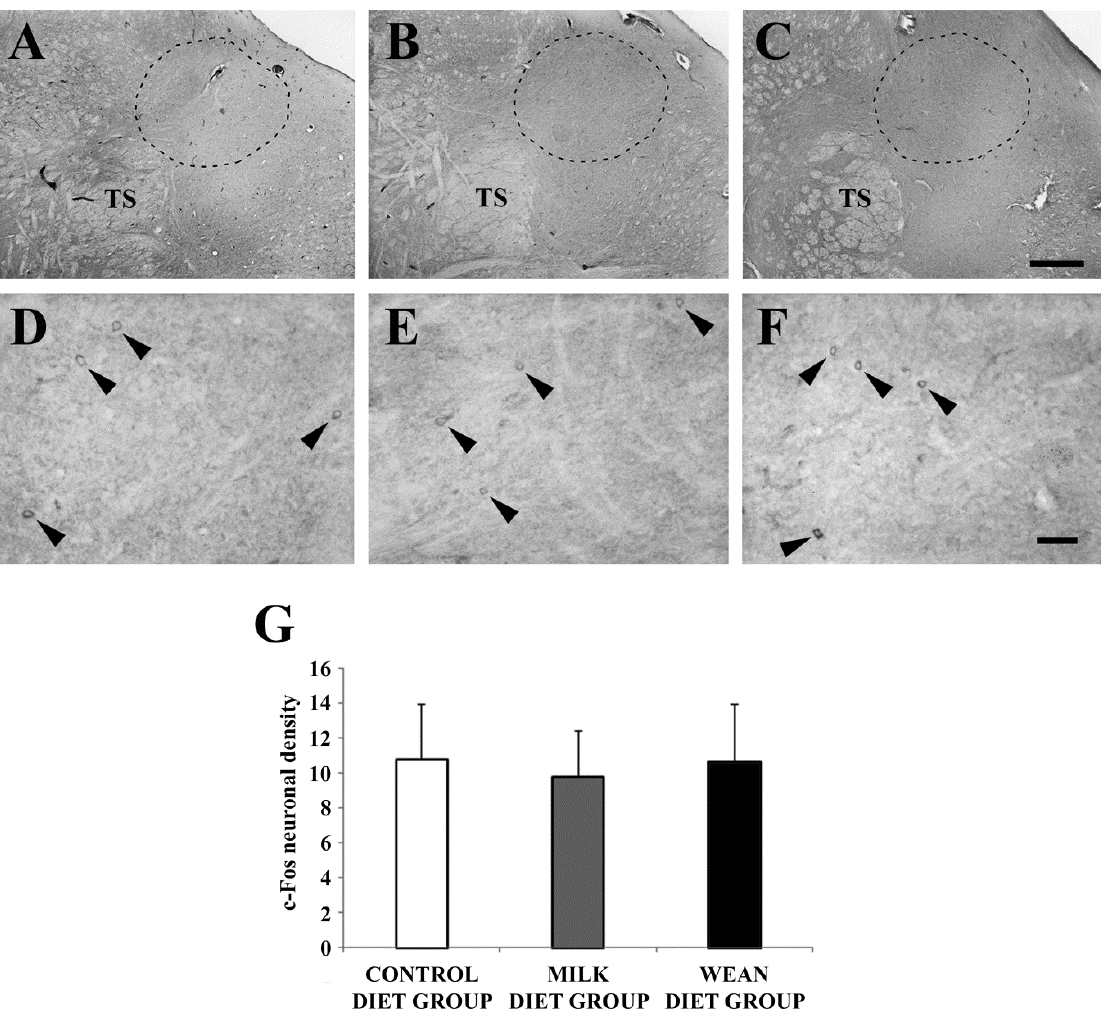
Figure 5. Brightfield photomicrographs of coronal sections ( A – F ) and histograms ( G ) showing the distribution of c-Fos immunoreactivity in the nucleus of the solitary tract (bounded by the dotted line) (A2 group) of the control diet group ( A , D ), milk diet group ( B , E ), and wean diet group ( C , F ). The density (number of somata / mm 2 ) of c-Fos-immunoreactive neurons is very similar in the di ff erent groups (arrowheads). Scale bars = 500 µ m in ( C ) (applies to ( A – C )); 20 µ m in ( F ) (applies to ( D – F )). Abbreviations: TS, tractus solitarius .